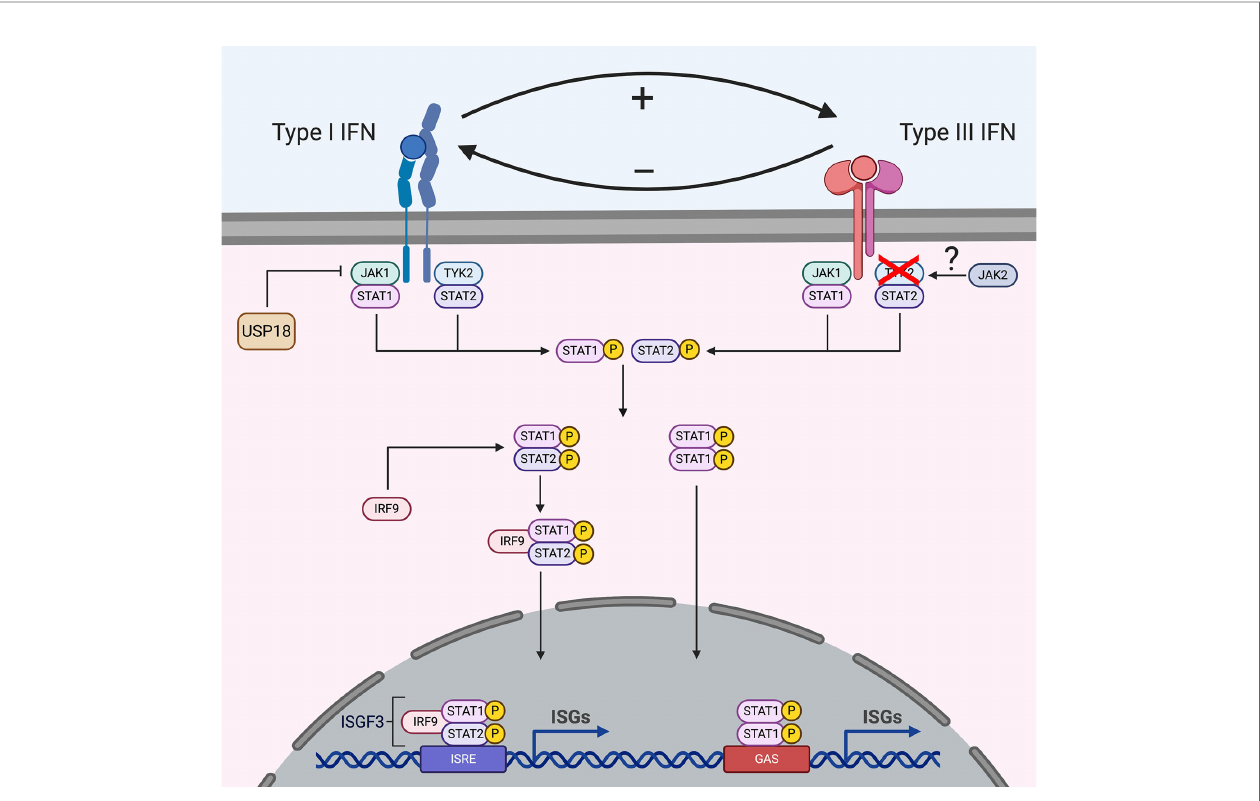
FIGURE 2 | Signal transduction downstream type I and type III IFN receptors. Upon binding to their receptors, IFNs induce the activation of the JAK/STAT signaling cascade. Both type I and III IFNs use JAK1 for their signaling, while type I IFNs also require TYK2 activation, type III IFNs signal independently of TYK2. Several studies suggest that type III IFNs use JAK2 for their signaling while type I interferons do not require JAK2. However, how JAK2 interacts with the receptor complex is currently unknown. Following JAK activation, STATs are recruited and activated which leads to their dimerization and binding to IRF9 forming the ISGF3 complex or homodimer complexes which translocates into the nucleus and drives ISG production. Some ISGs act as negative regulators and the ISG USP18 is known to regulate type I IFN signaling but not type III IFN